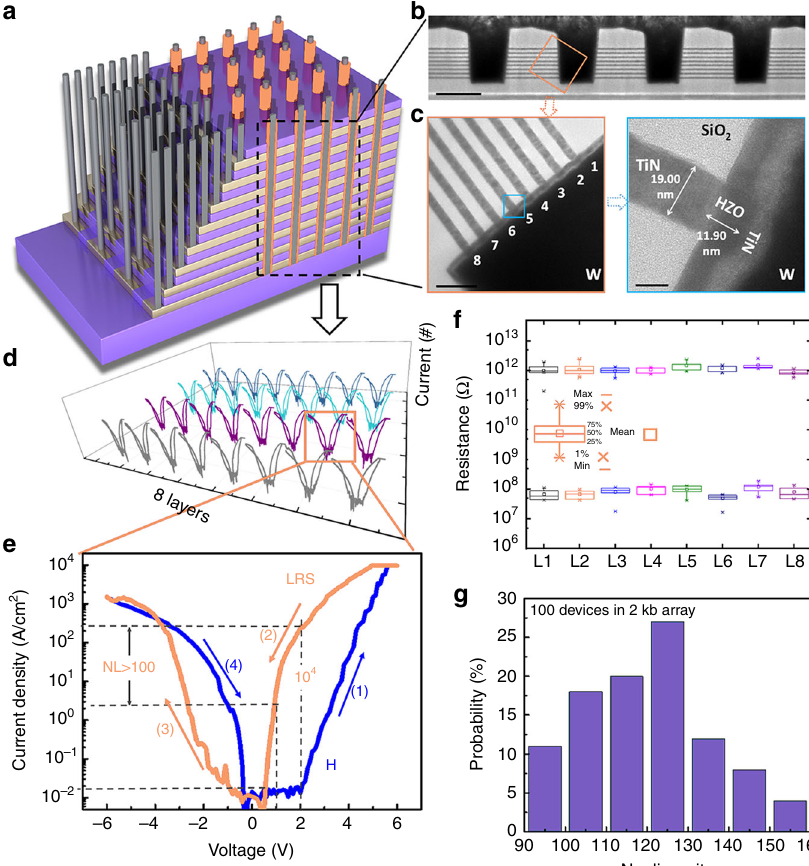
Fig. 4 High-density 3D integration of the ferroelectric diode devices. a A schematic view of the 8-layer 3D vertical ferroelectric diode (Fe diode) array. b Cross section of the 3D vertical structure with Fe diode devices and the detailed structure information for the devices, where a 417.5-nm hole structure and 8-layer vertical memory cells can be observed clearly. Scale bar, 500 nm. c The cell size was de fi ned by the thickness of the TiN and the perimeter of the holes (19 nm × 1.31 μ m). Scale bar (left), 10 nm. Scale bar (right), 10 nm. d I – V curves of the Fe diode devices in the 4 × 8 array framed in ( a ). e Typical I – V curve of the TiN/Hf 0.5 Z 0.5 rO 2 /TiN/W device. Switchable diode property was achieved. In this device, low operation current (<1 nonlinearity (>100) were achieved. f Resistance distributions of the switchable diode device in the 8-layer array. g Distribution of the nonlinearity in 3D array.